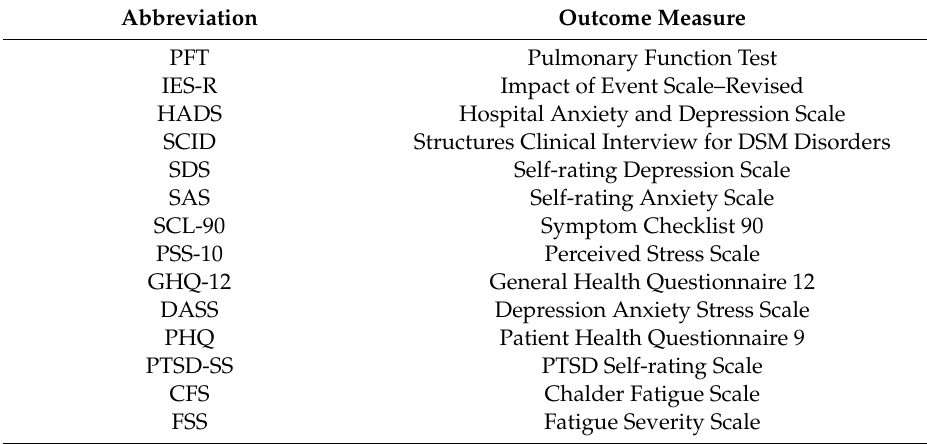
Table 1. Outcome measure abbreviations.